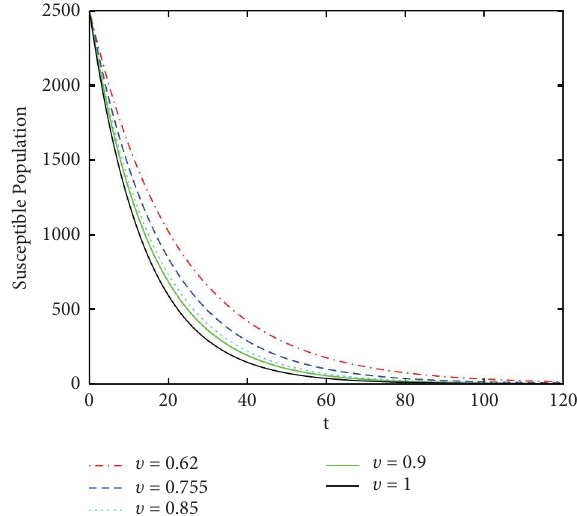
Figure 14: Te dynamics of susceptible human population for various fractal orders π and for fractional order υ � 0 . 5.